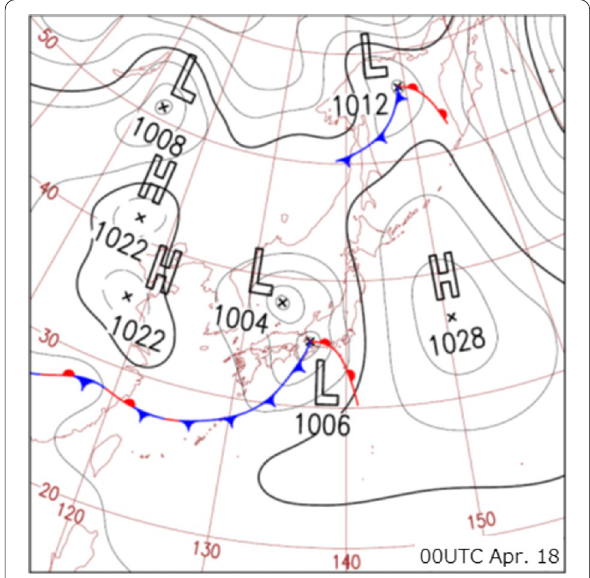
Fig. 3 Weather chart for Japan and surrounding areas at 0:00 UTC